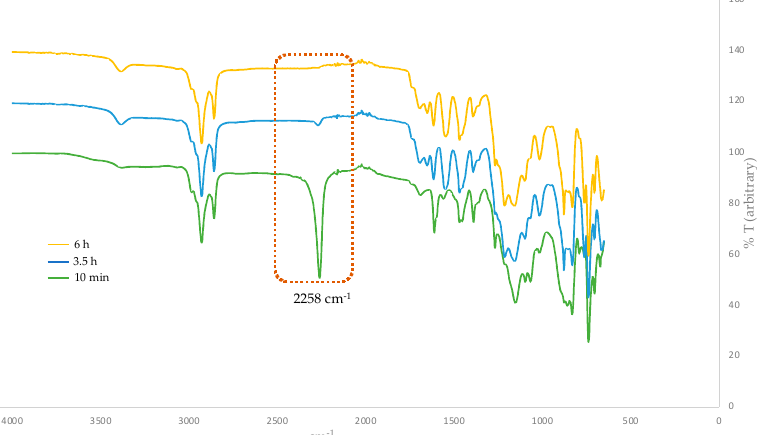
Figure 1. Progress of BF 3 .OEt 2 -catalyzed reaction involving the attachment of dendron to the core monitored by FT-IR spectroscopy. The isocyanate N=C=O stretch at 2258 cm − 1 disappears over time.